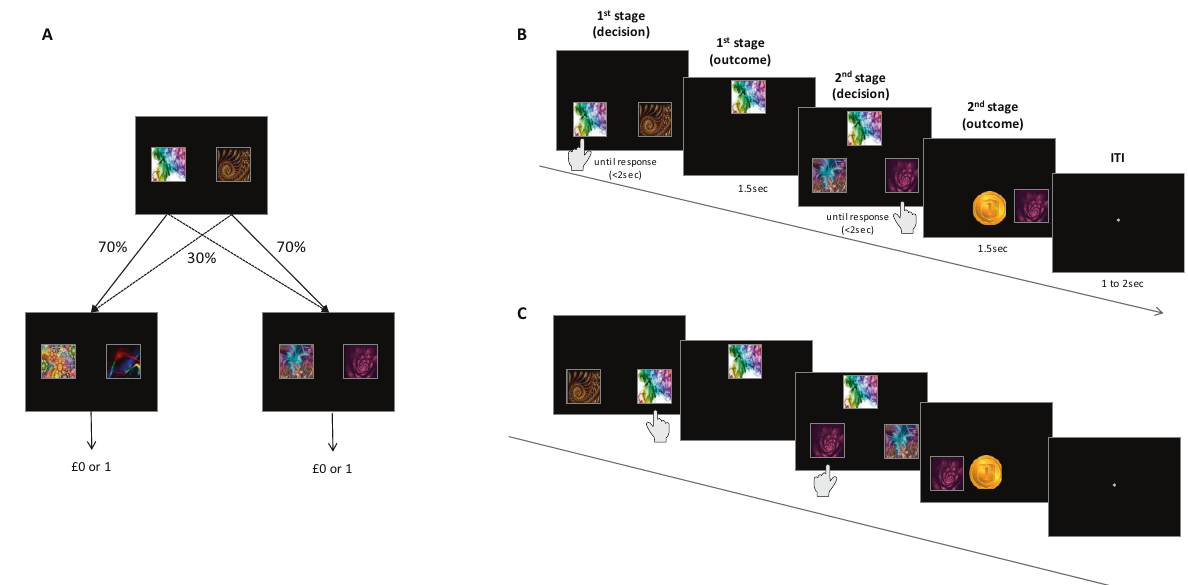
Fig. 2 Two-step task illustration. A Participants navigated between the two stages of the task in order to reap rewards. The second stage included two pairs of fractal images, which led probabilistically to a reward. To attain these rewards, participants made choices during the fi rst stage, which probabilistically determined the fractals presented during the second stage. B Illustration of trial sequences, showing a choice made in the fi rst stage, followed by feedback, and a second-stage selection that was followed by a reward (1 play pound). C A fractal to response key pairing was allocated randomly in each trial. Panel ( C ) illustrates a trial sequence, in which the same fractals were selected as in panel ( B ), but now with different effectors. Although fractal identity predicted relevant outcomes (second-stage fractals, and reward), the position of the fractal and the response key used to report a selection were always outcome-irrelevant. Outcome-irrelevant learning was inferred from a participant ’ s tendency to assign value to response keys despite their irrelevance to any individual decision (see Fig. 3 for outcome-irrelevant estimate plots). Model-based control was estimated as the ability to select a fi rst-stage action based on the task ’ s transition probability and subjective action values of second-stage fractals [14, 31] (see Supplementary Fig. S3 for model-based estimate